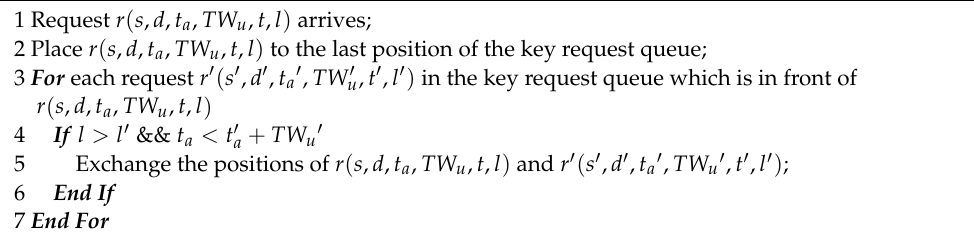
Algorithm 1. Time-window-based security orchestration (TW-SO) strategy.